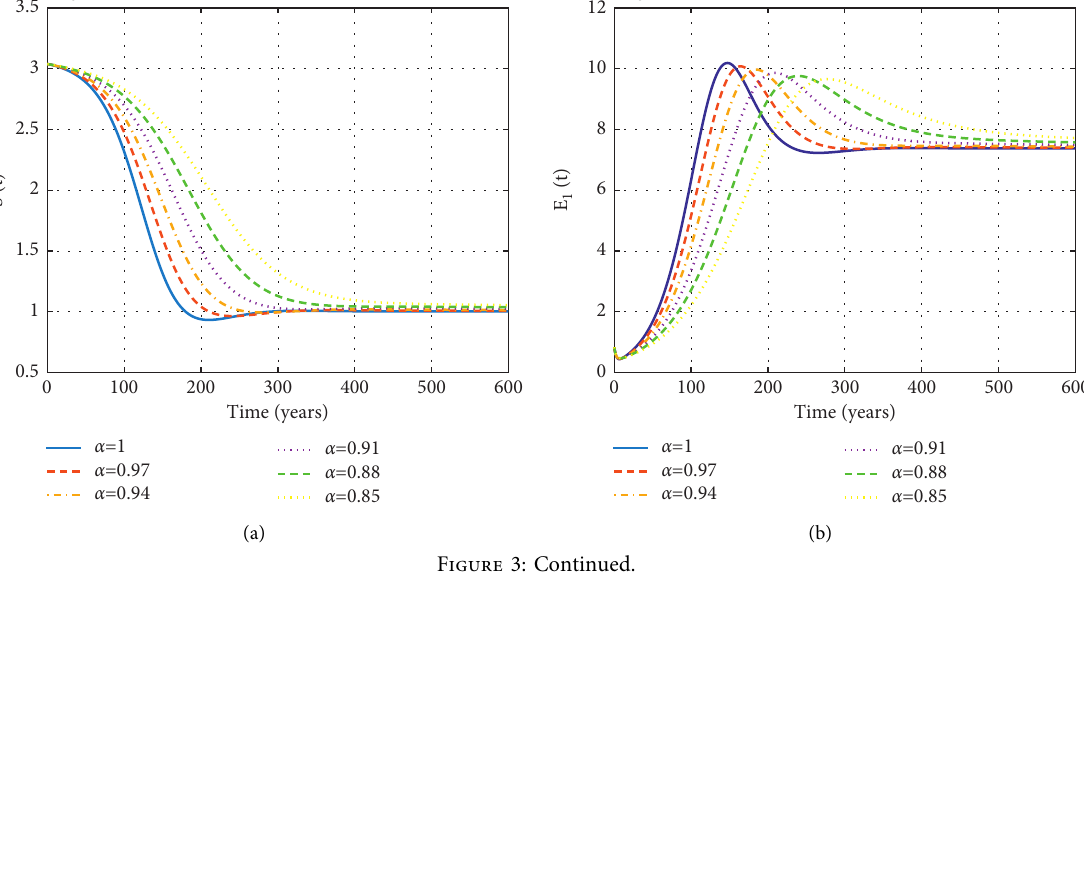
Figure 2: Numerical visualization of cumulative infected compartments of the TB model when R